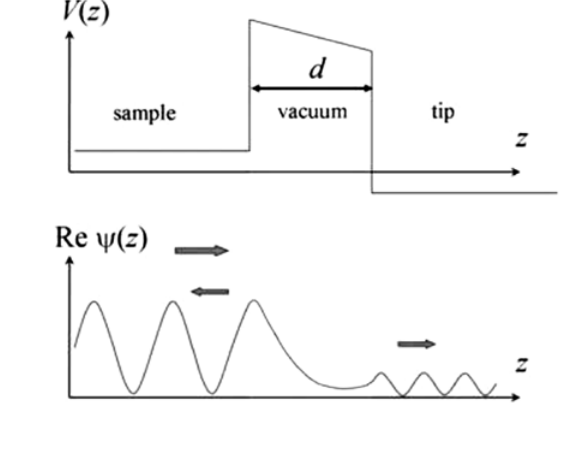
Fig. 1. The trapezoidal potential barrier energy structure and the real part of the electron wave function near the boundary of the sample and the